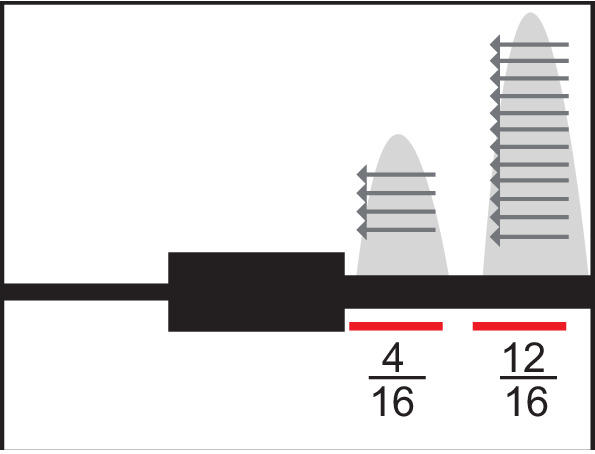
Model representation of usage calculation.Representation of polyadenylation sites (PAS) usage calculation. Usage is a ratio of reads at each PAS to the number of reads mapping to any PAS in the same gene. Reproduced from Mittleman et al., 2020.